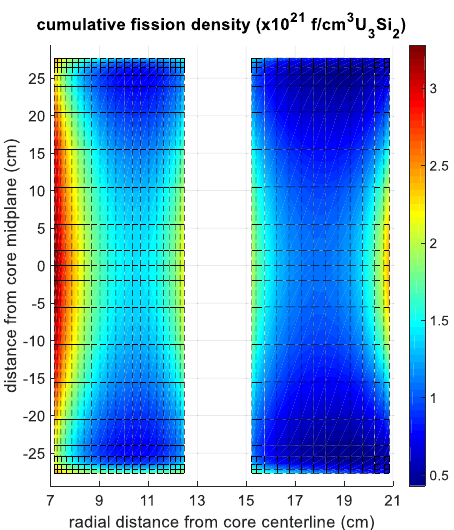
Figure 5. End-of-cycle fission rate density. Figure 6. Cumulative fission density.